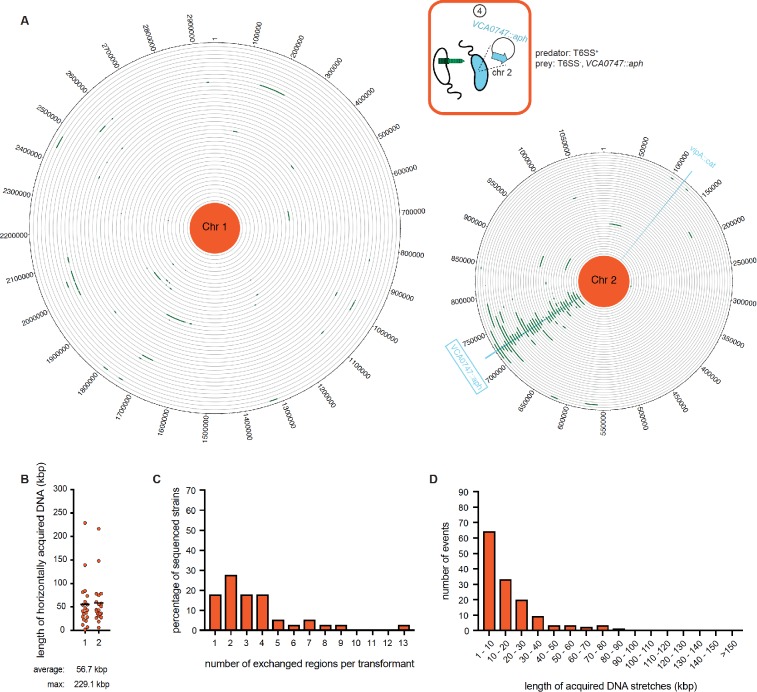
WGS-based quantification of horizontally acquired DNA under condition ④.Details as described for Figure 3 with the addition of the map of both chromosomes in panel A.